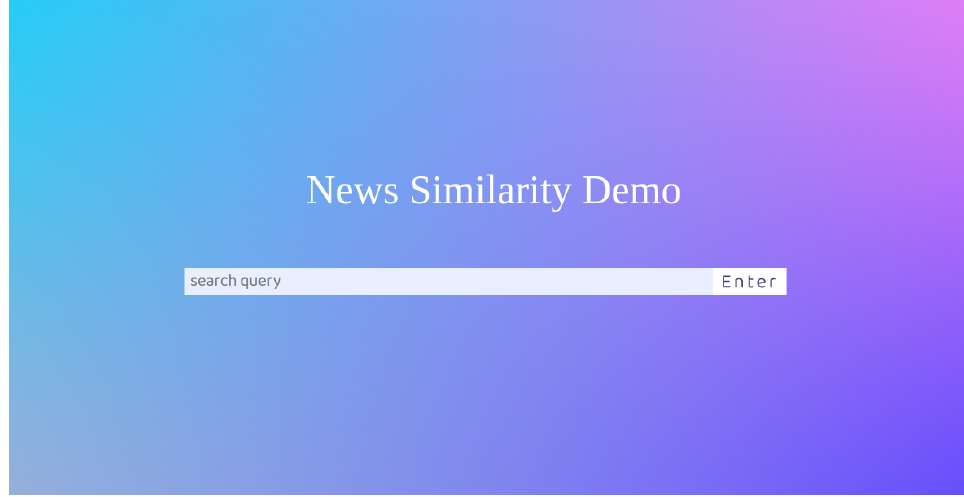
Figure A5. Starting page of the Multiverse demonstration system.